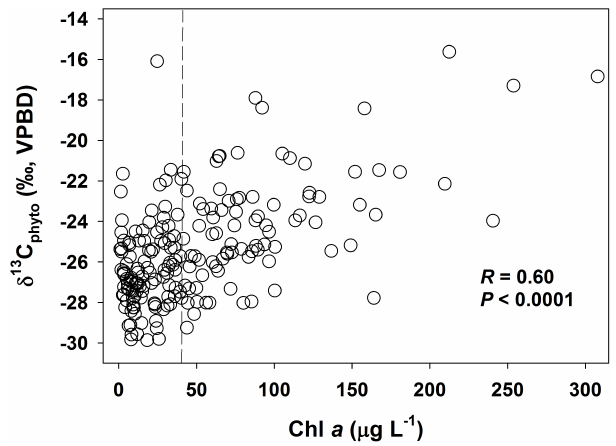
Figure 3. Correlation between phytoplankton δ 13 C and chloro- phyll a , indicating that isotopic enrichment increased with phyto- plankton biomass. The dashed line indicates phytoplankton bloom conditions, defined here as >40µg Chl a L − 1 (Bachmann et al., 2003).